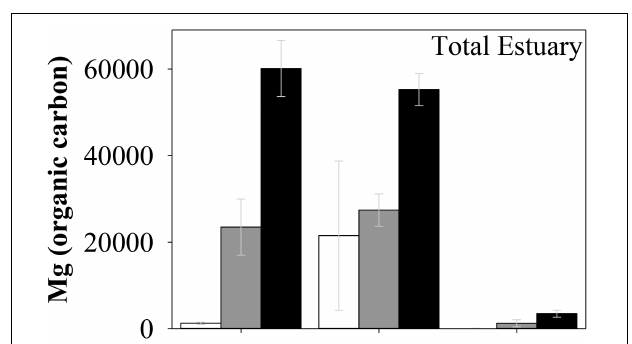
FIGURE 4 | Total carbon stock estimates for seagrass, mangrove and saltmarsh in Coffs Creek (white), Corindi estuary (gray), and Wooli estuary (black) (Mg C). Error bars indicate the standard